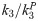
Noise induced bias for Ki and λk3 estimated by BAFPIC and for Ki estimated by Patlak plot as function of k3/k3P.The simulated noise corresponds to TACs that are regularly observed at the HRRT voxel level (sf = 120). Bias is computed as ((measured-simulated)/simulated)%. Note that the yellow line in this figure corresponds to the yellow line in Fig 5.